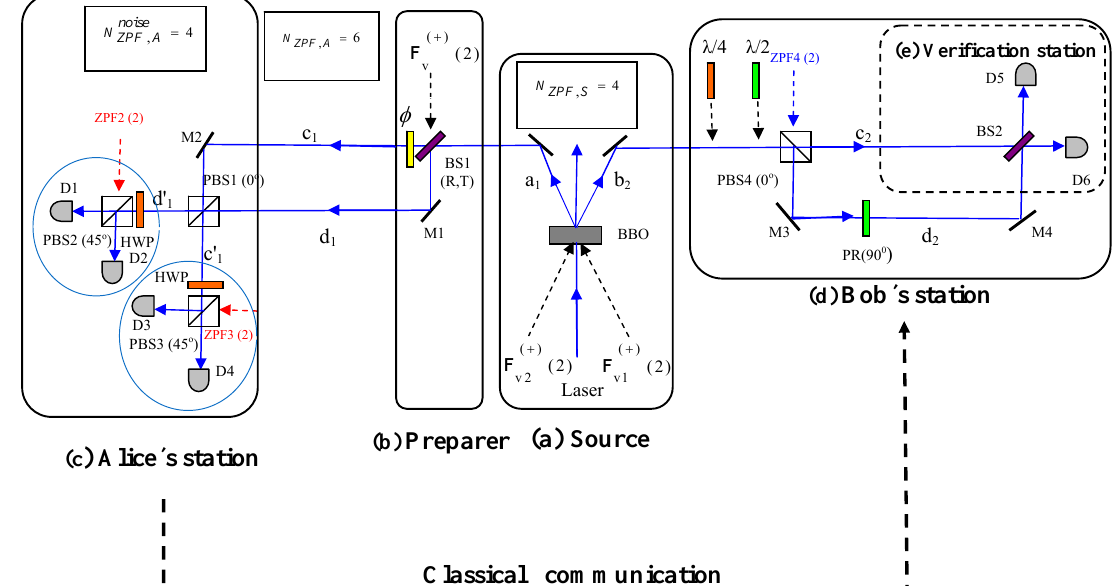
Figure 4. Zeropoint field entries corresponding to the diagram of the setup for teleportation [51]. The information concerning the number of sets of ZPF modes is written in brackets. ( a ) Source (+) (+) ( N ZPF , S = 4). The inputs F and F , each of them containing two sets of vacuum modes, are v 2 v 1 activated and coupled with the laser inside the crystal, so that polarisation entanglement is generated. ( b ) Preparer . BS1 is a variable ( R , T ) beam-splitter that introduces a pair of additional sets of vacuum modes, which are necessary to prepare photon 1 in the momentum state T exp ( i φ ) | c (cid:105) 1 + iR | d (cid:105) 1 . This state is teleported to photon 2 by using polarisation entanglement. ( c ) Bell-state analyser ( N ZPF , A = 6). PBS1 does not introduce additional zeropoint modes. PBS2 and PBS3 transmit 45 ◦ polarisation and = 4). ( d ) Bob’s station . reflect − 45 ◦ . Each of them adds two pairs of zeropoint modes ( N noise ZPF , A After knowing which detector clicked, Alice communicates through a classical channel the necessary information to Bob in order to reproduce the momentum state of photon 1 in photon 2, by just performing a unitary transformation. He uses quarter-wave-plate ( λ /4) and half-wave-plate ( λ /2), PBS4 and a polarisation rotator PR(90 ◦ ). The idle channel of PBS4 introduces two sets of vacuum modes which are necessary in order to reproduce the prepared state. ( e ) Verification station . The rest of the setup on Bob’s side, a balanced beam-splitter BS2 and detectors D5 and D6, is intended to check that teleportation has been